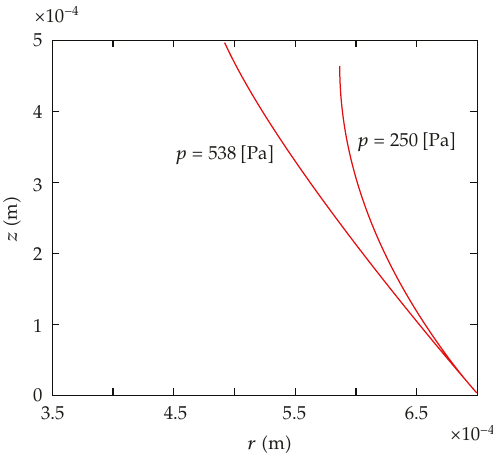
Figure 6: z versus r for p (cid:2) 538 , 250 (cid:5) Pa (cid:7)